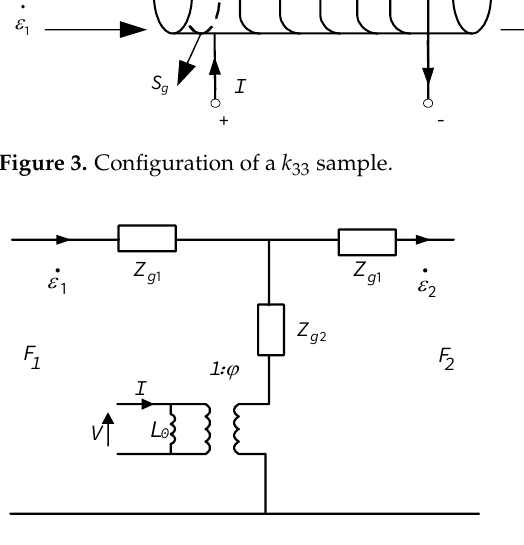
Figure 4. PWM equivalent circuit without material losses.